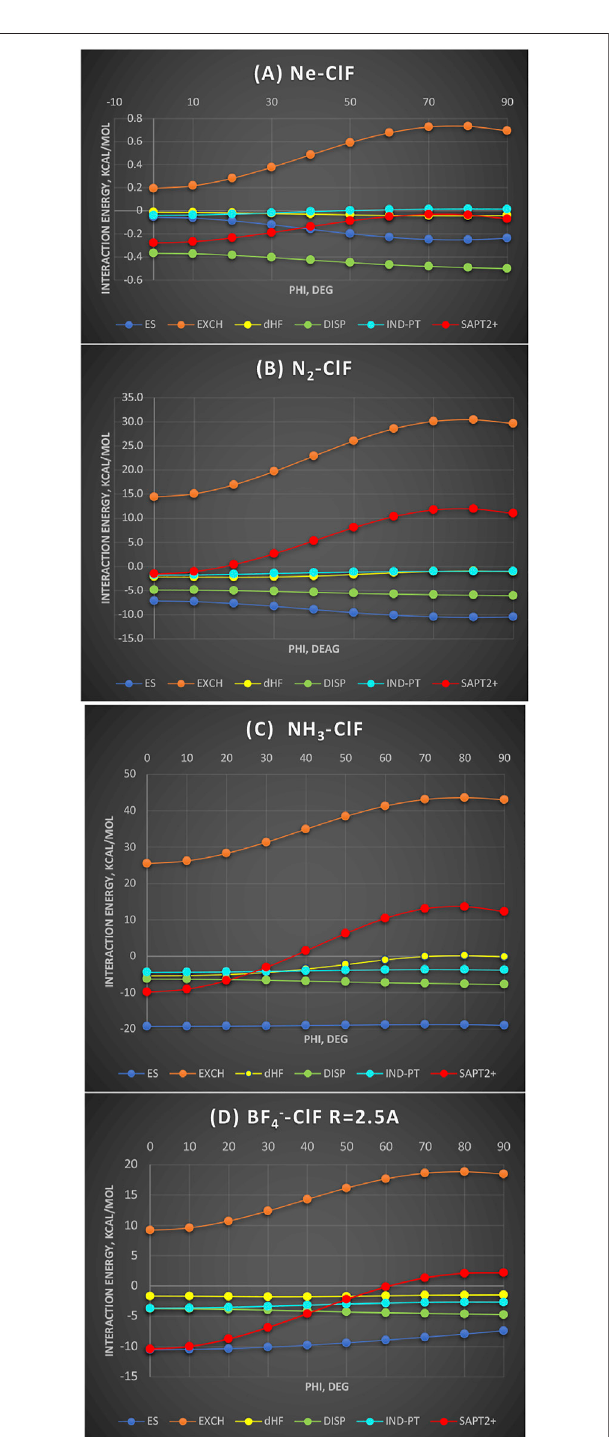
FIGURE 5 | SAPT energy components as a function of ClF bending around the Cl atom (denoted phi); values in kcal/mol. (A) Ne-ClF at the sum of van der Waals radii distance 3.3 Å; (B) N 2 -ClF at the N-Cl distance 2.5 Å; (C) NH 3 -ClF at the N-Cl distance 2.5 Å; (D) BF 4 − -ClF at the intersystem F − -Cl distance 2.5 Å.